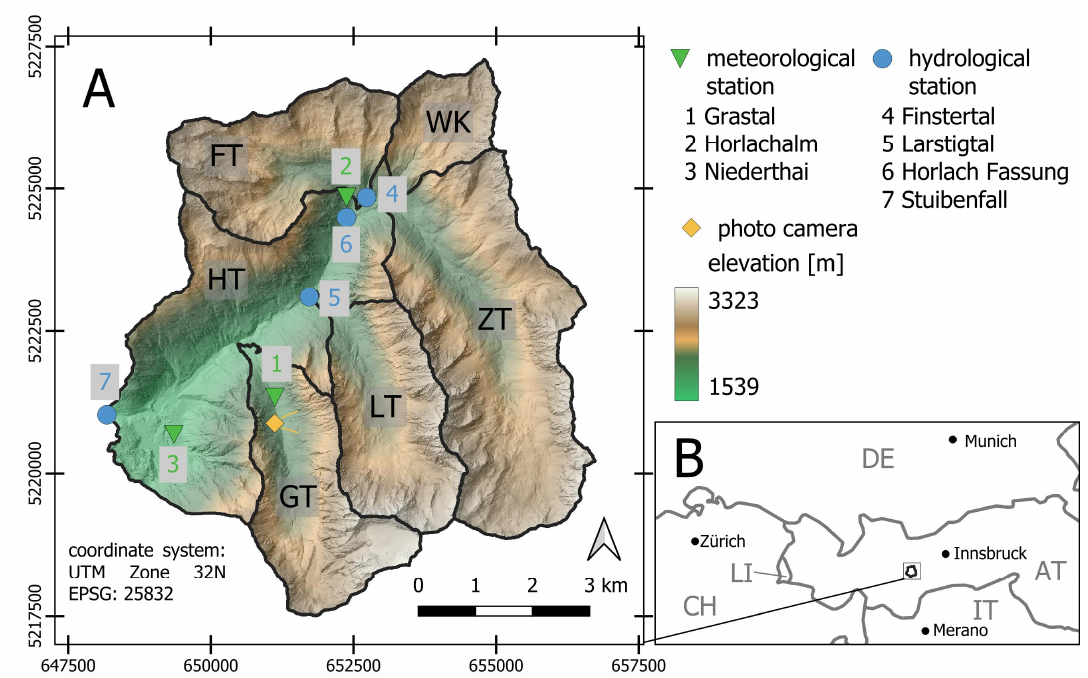
Figure 1. ( A ): The Horlachtal with its sub-catchments presented with a hillshade generated based on the 2022 LiDAR data. The locations of the stations mentioned are shown as well. ( B ): Location of the study area. Table 1. The sub-catchments of the Horlachtal and their main properties. Sub-Catchment Area [km 2